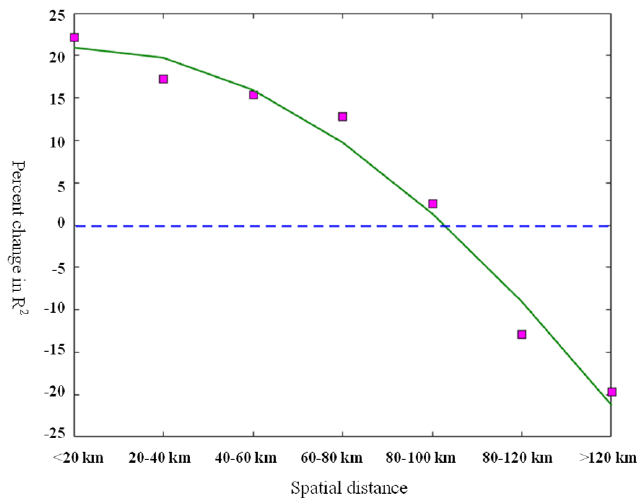
Figure 5. Percent change in R 2 from the GLM to the BME model for different spatial distance. Second, we combined the information from GLM and BME models according to the distance between the measurement point and its closest monitoring site ( dist ).